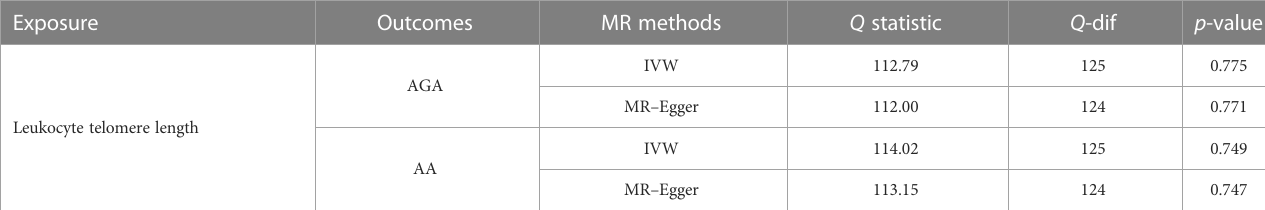
TABLE 1 Heterogeneity analysis of the leukocyte telomere length-related genetic variants in the androgenetic alopecia and alopecia areata GWAS datasets. Exposure